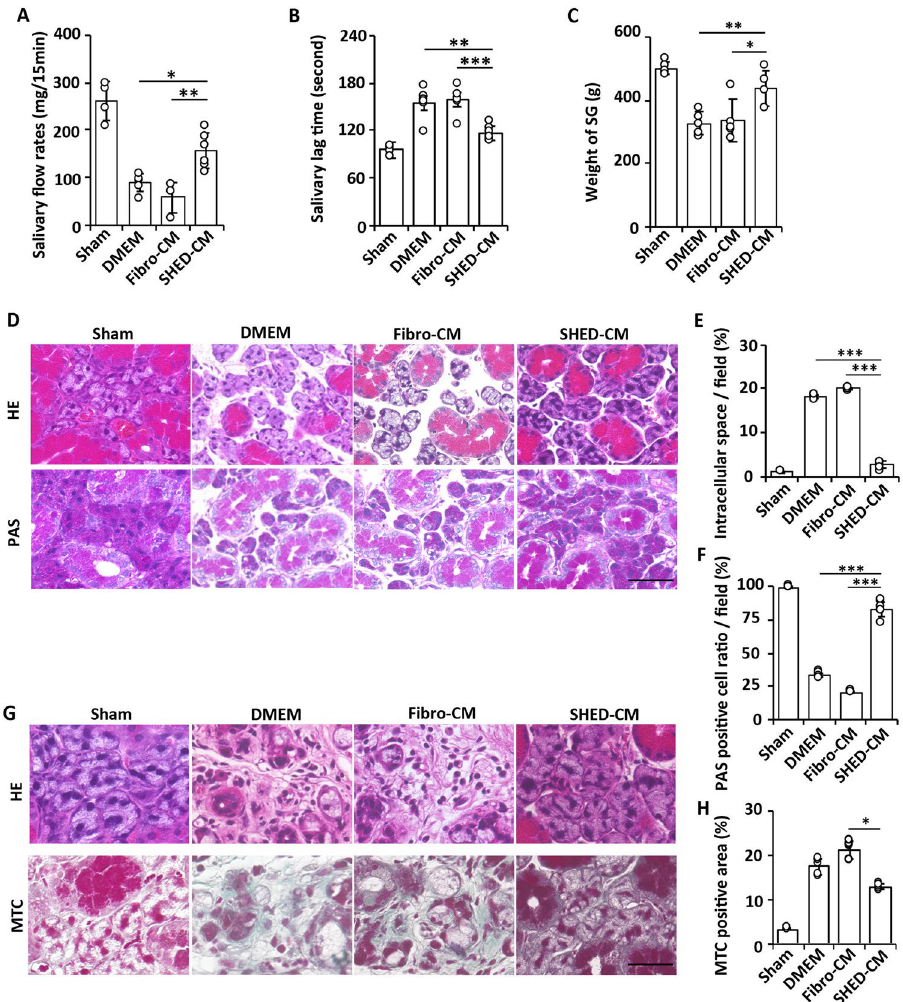
Figure 2. Intravenous administration of SHED-CM improves radiation-induced mouse SG injury. ( A – C ) Changes in salivary flow rates ( A ) and lag times ( B ) a week after the last treatment and SG weight ( C ) 12 weeks after treatment. ( D ) Images of the H&E or PAS staining of SG 24 h after the last CM treatment (n = 6). Scale bar: 100 μm. ( E ) Quantification of the intercellular space in H&E staining (the data presented by percent area per 250-μm 2 field). ( F ) PAS-positive cell ratio in the total acinar cell number in 250-μm 2 field. ( G ) Images of the H&E and MTC staining of SG at 12 weeks (n = 6). ( H ) Quantification of MTC-positive area (the data presented by percent area per 250-μm 2 field). Scale bar: 100 μm. The results are expressed as mean ± SD. Comparisons between groups were analyzed using an ANOVA with Tukey’s multiple comparison test [( A – C ), ( E ), ( F )], or a Kruskal–Wallis test/Dunn’s multiple comparison test (H) (* p < 0.05, ** p < 0.01, *** p < 0.001). CM, conditioned medium; SHED, stem cells from human exfoliated deciduous teeth. CM, conditioned medium; Fibro, fibroblast; SG, salivary gland; SHED, stem cells from human exfoliated deciduous